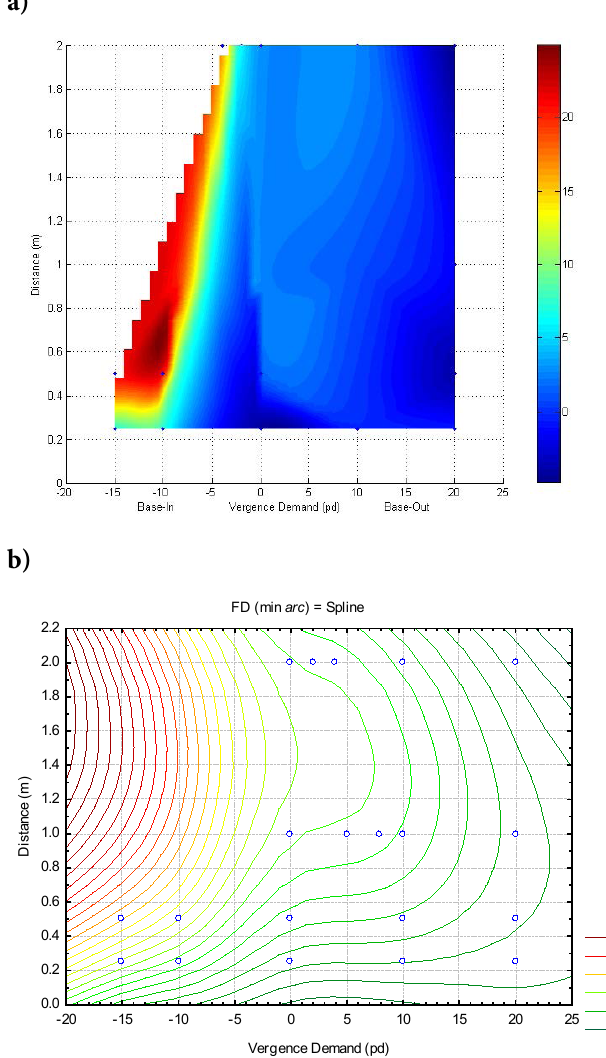
Figure 5 . Surfaces of forced vergence disparity for Subject